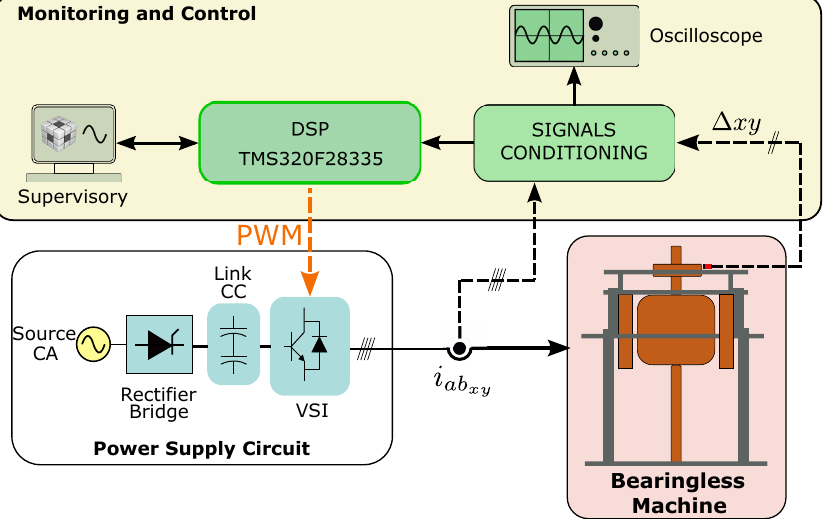
Figure 10. Overview of the components of the experimental bench.